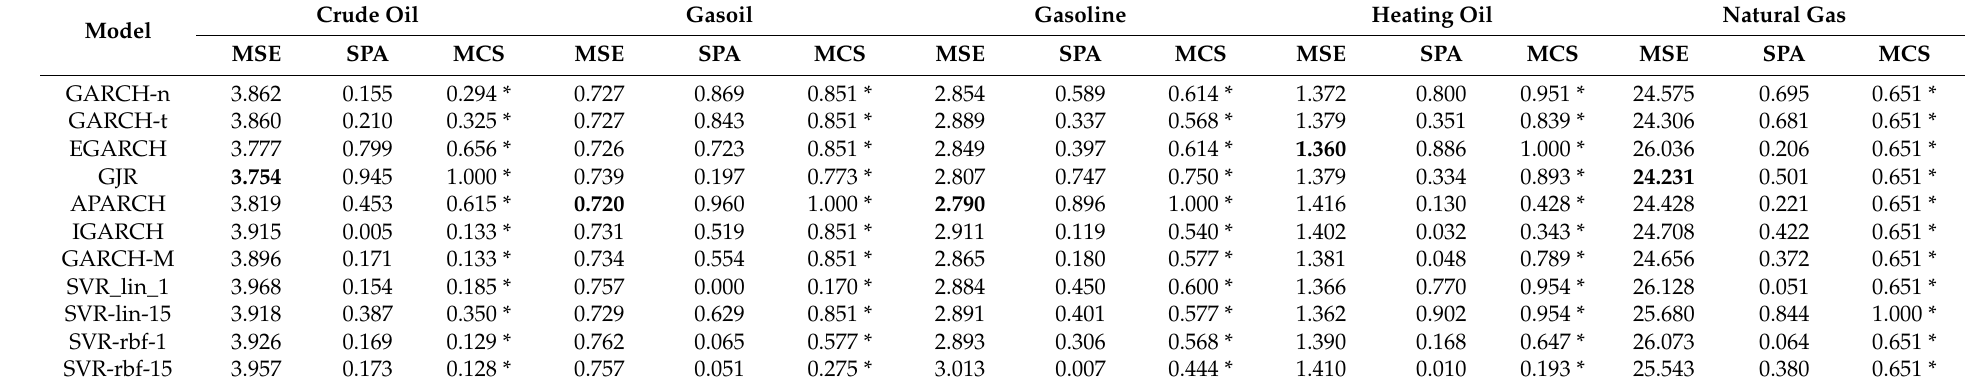
Table 2. Evaluation of the variance forecasts in terms of the MSE measure for the squared daily returns used as a proxy of